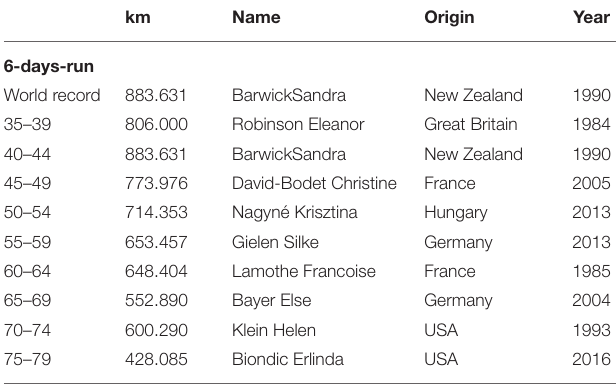
TABLE 4 | World records in women in elite and age group athletes in time-limited races, from